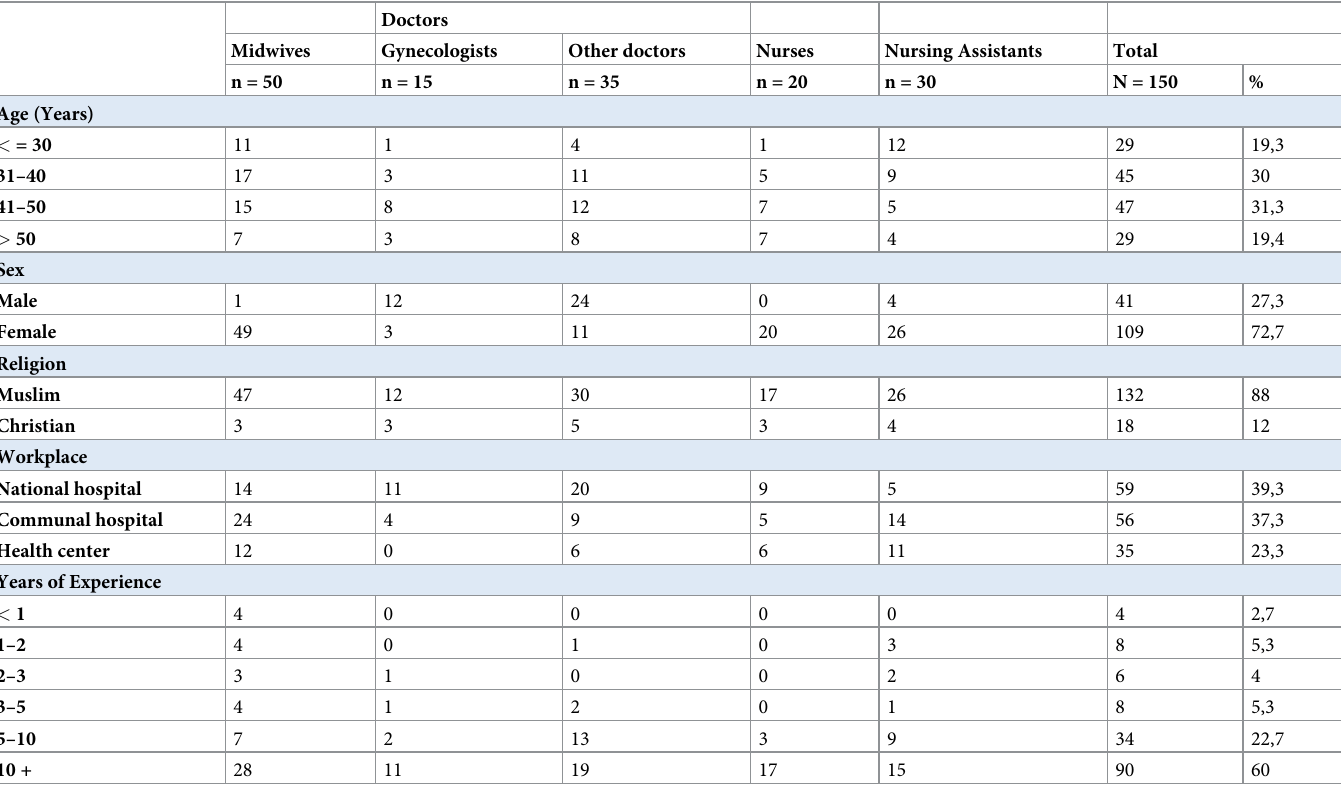
Table 2. Socio-demographic characteristics of health care providers in the quantitative component (n =